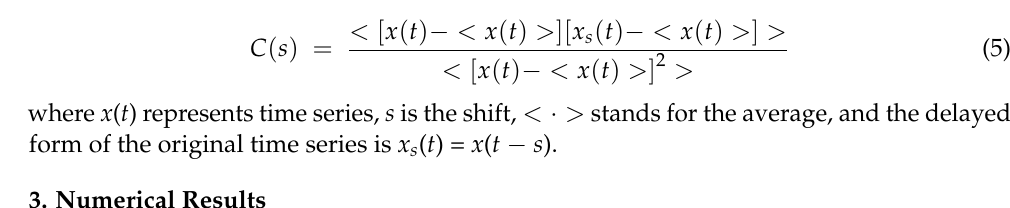
Figure 1. The two − dimensional map of the 0–1 test for chaos of MSRL in the ( (a1,a2,a3,a4) : 0–1 test of the CW outputs, (b1,b2,b3,b4) : 0–1 test of the CCW outputs; (a1,b1,a2,b2): =6 ns f